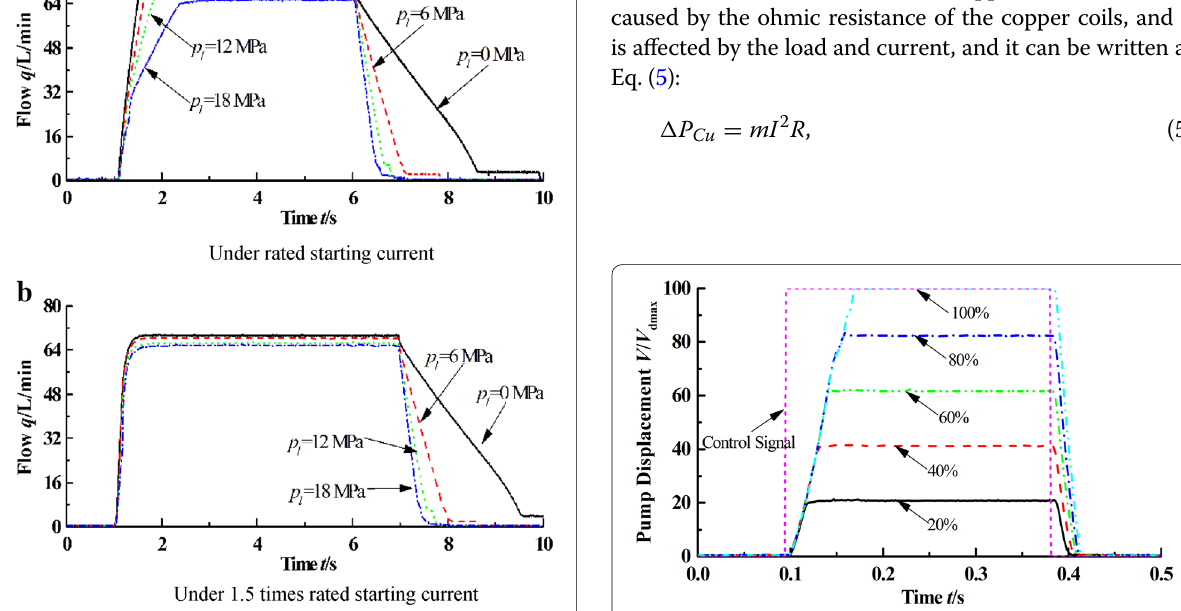
Figure 3 Starting and braking characteristics of electro-hydraulic power source